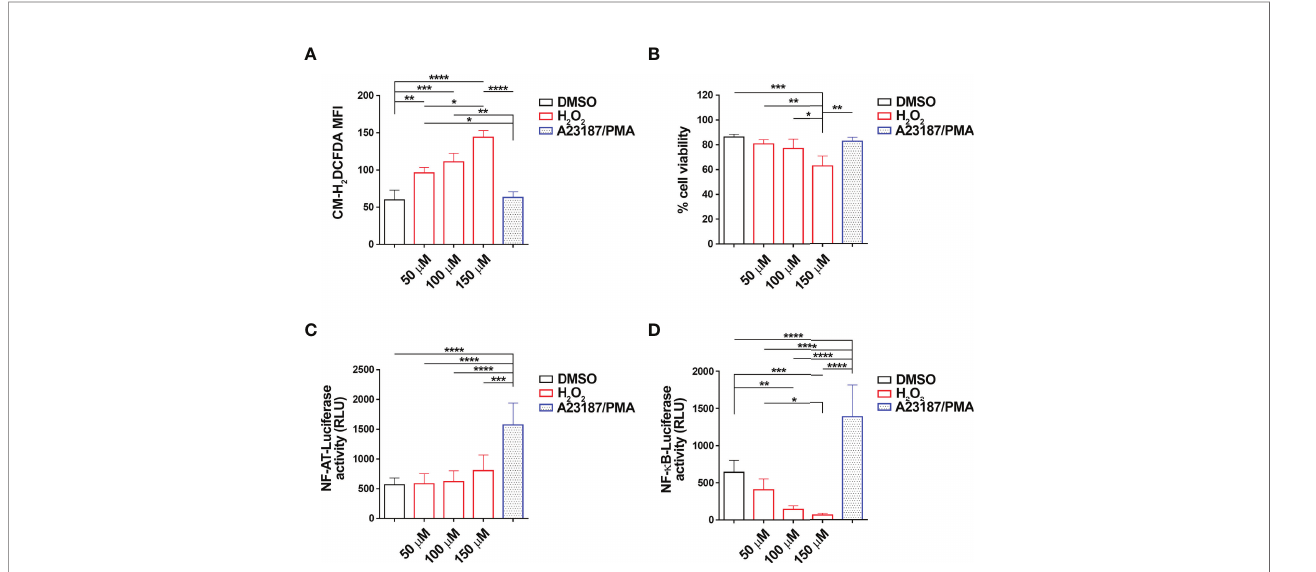
FIGURE 1 | H 2 O 2 suppresses NF- k B activity in MEC-1 cells. (A – D) . Quanti fi cation of the luciferase activity in MEC-1 cells transfected with either NF-AT-luciferase (C) or NF- k B-luciferase (D) reporter constructs and then treated for 6 h with H 2 O 2 at the indicated concentrations. Data are expressed as relative luciferase units (RLU). A combination of A23187 and PMA was used as positive control (n independent experiments = 4). A mix of cells transfected with the two constructs and treated as above were used for the fl ow cytometric analysis of ROS intracellular content in cells stained with 5 m M CM-H 2 DCFDA (A) and of cell viability, calculated as the percentage of Annexin V - /PI - cells (B) (n independent experiments = 4). Mean ± SD. Anova two-way test, Multiple Comparison. p ≤ 0.0001, ****; p ≤ 0.001, ***; p ≤ 0.01, **; p ≤ 0.05,